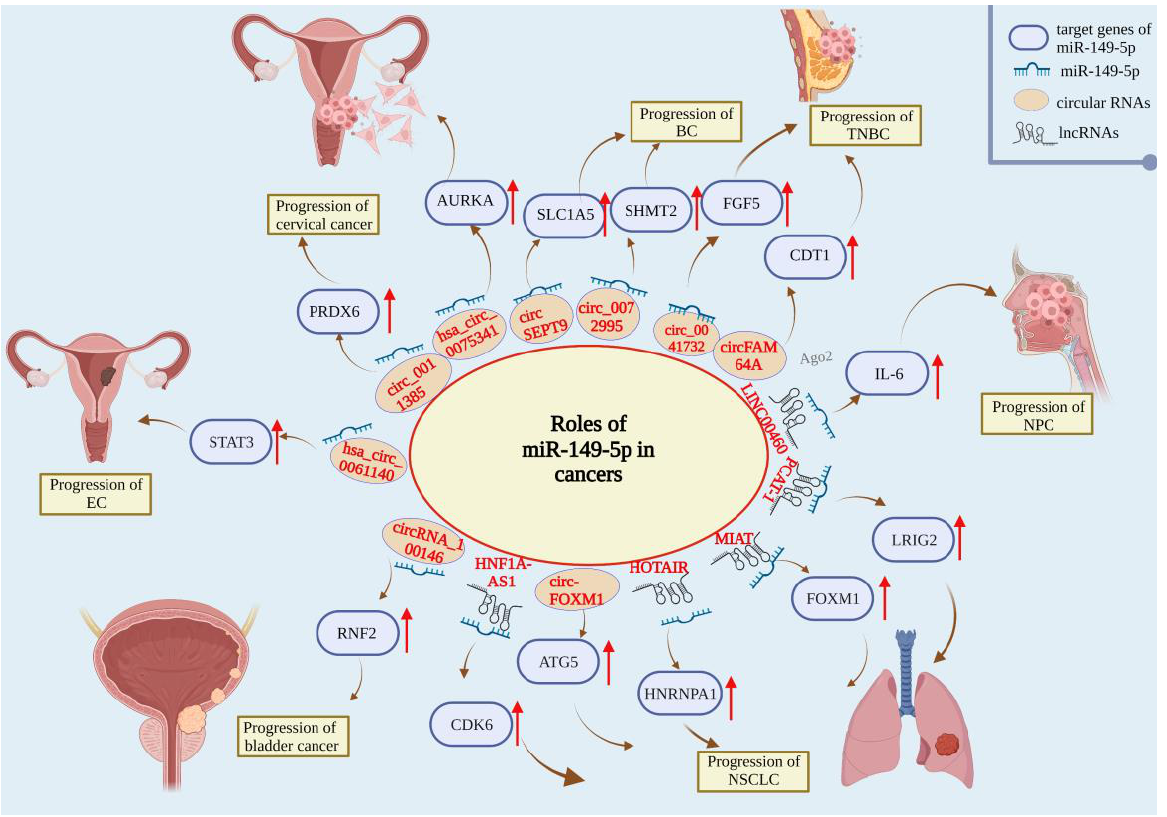
Figure 2. Roles of miR-149-5p in non-small cell lung cancer (NSCLC), nasopharyngeal carcinoma (NPC), breast cancer (BC), triple-negative breast cancer (TNBC), cervical cancer, endometrial carci- noma (EC), and bladder cancer.